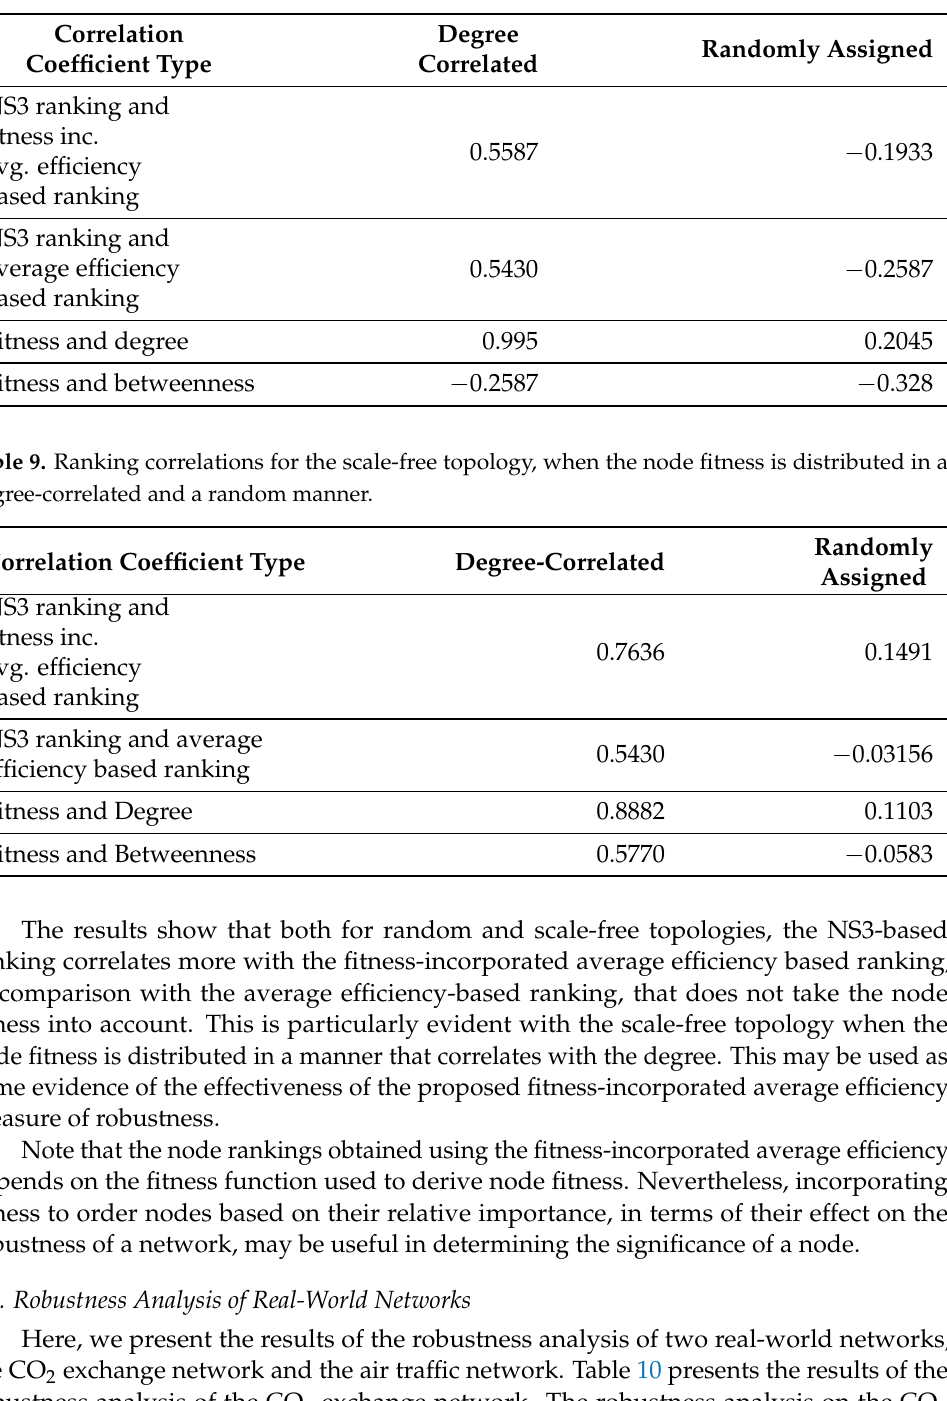
Table 8. Ranking correlations for the Random topology, when the node fitness is distributed in a degree-correlated and a random manner.